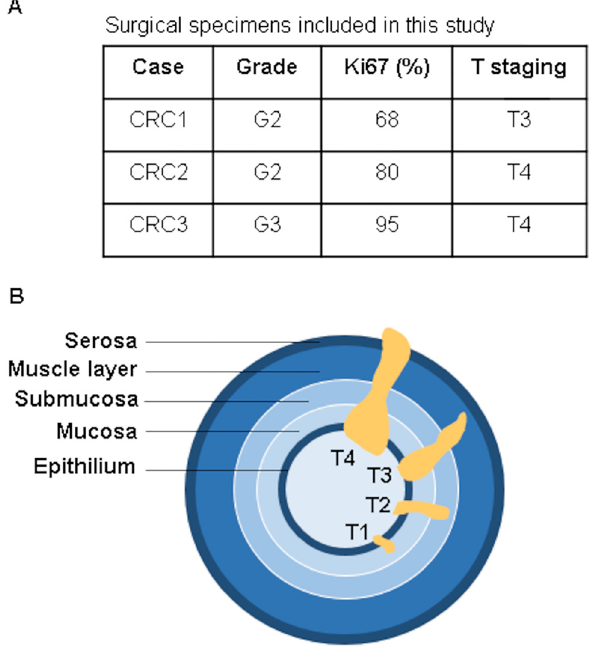
Figure 13: Staging and grading of colorectal cancers studied. (A)CRC1andCRC2aremoderatelydifferentiated(gradeG2)whereas CRC3 is poorly differentiated (grade G3). In all three samples, more than60%ofcellsexpressKi67,whichrevealsacellularstateofhigh proliferative activity.(B) Primarytumor(T)stagingclassi fi esCRC1as T3, invading through the muscle layer and both CRC2 and CRC3 as T4, invading through serosa and most likely reaching other